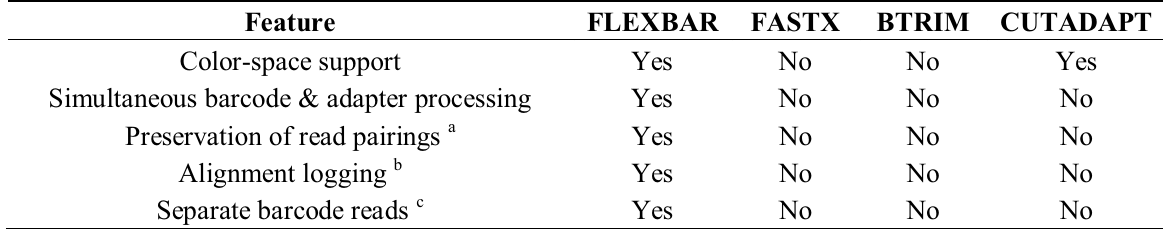
Table 1. Comparison of FLEXBAR features with other